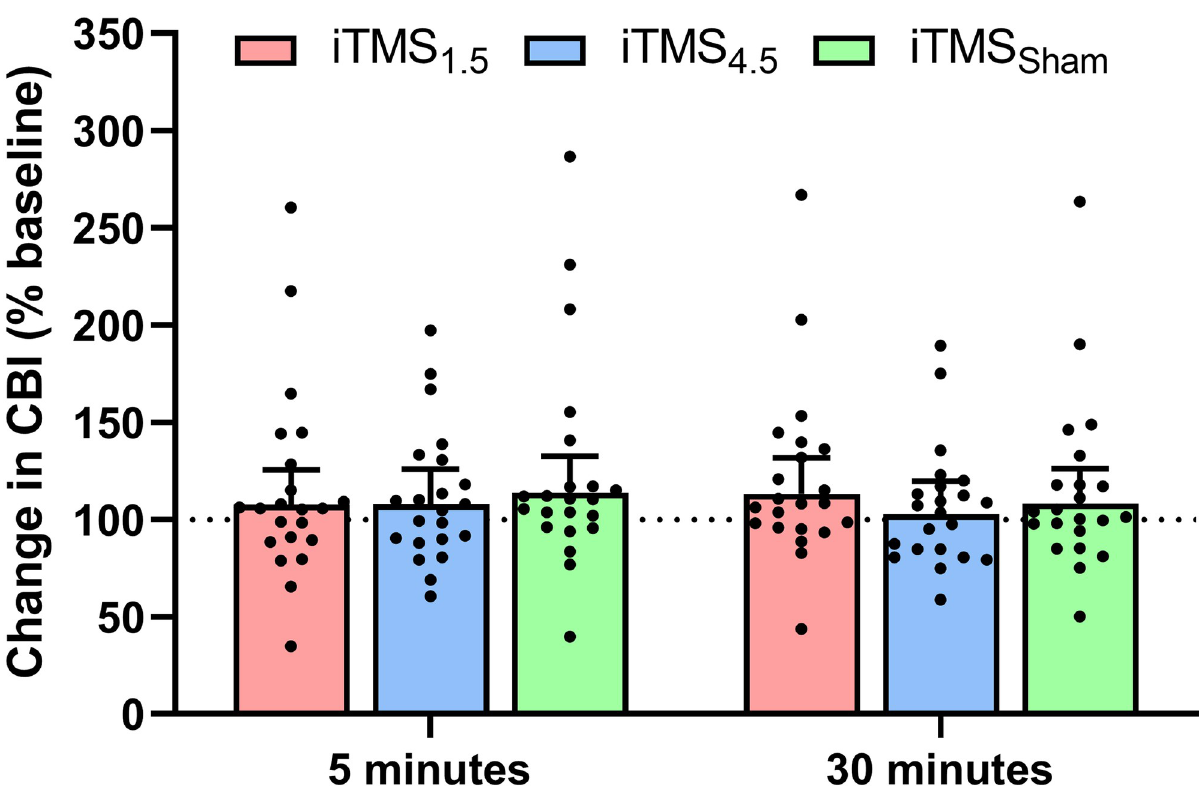
Fig 6. Changes in CBI following iTMS